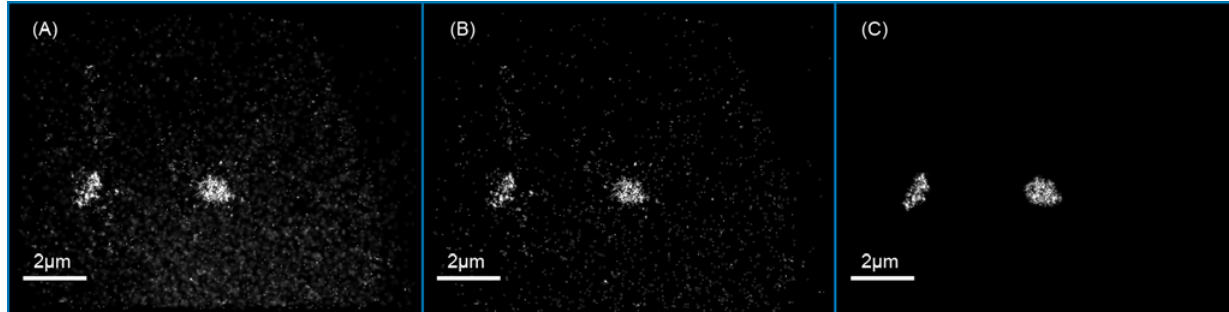
Figure 3. Examples of image sections of a mammary epithelial cell nucleus after COMBO-FISH of the centromeric region of chromosome 9 with repetitive PNA probes labeled with Alexa 488  ( λ = 495/519 nm). Two labeling clusters of individual probe ex/em molecules are visible ( A ) Localization image of all detected signals. ( B ) Detected signals with a localization accuracy better than 30 nm. ( C ) Localization image of those signal molecules that have more than 40 blinking neighbors within a circle of 200 nm radius.